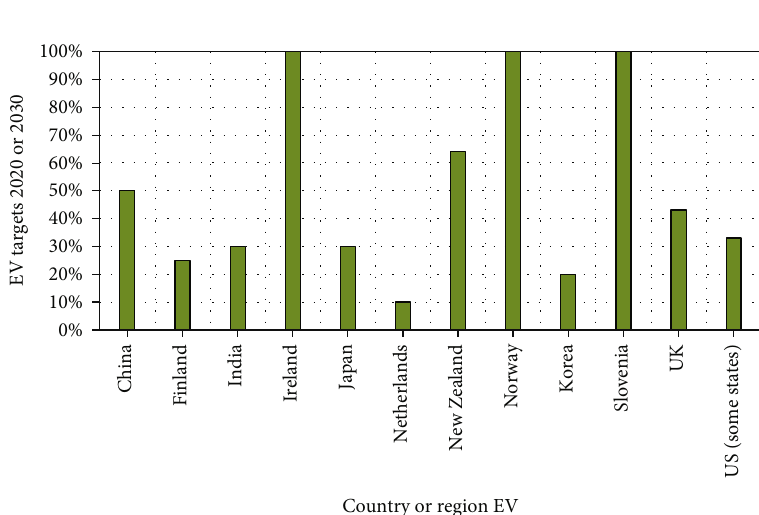
Figure 13: EV present and future targets by